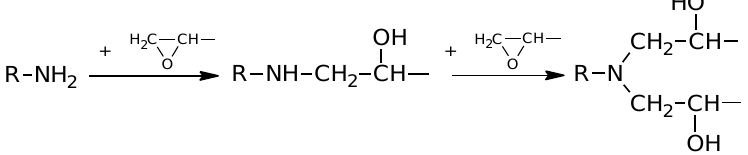
Figure 1. General scheme of the reaction of epoxy resin with amine.